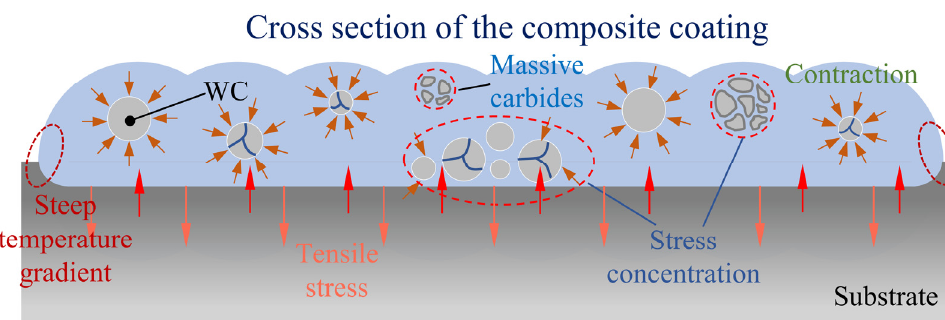
Figure 10. Mechanism of residual stress generation during laser cladding.